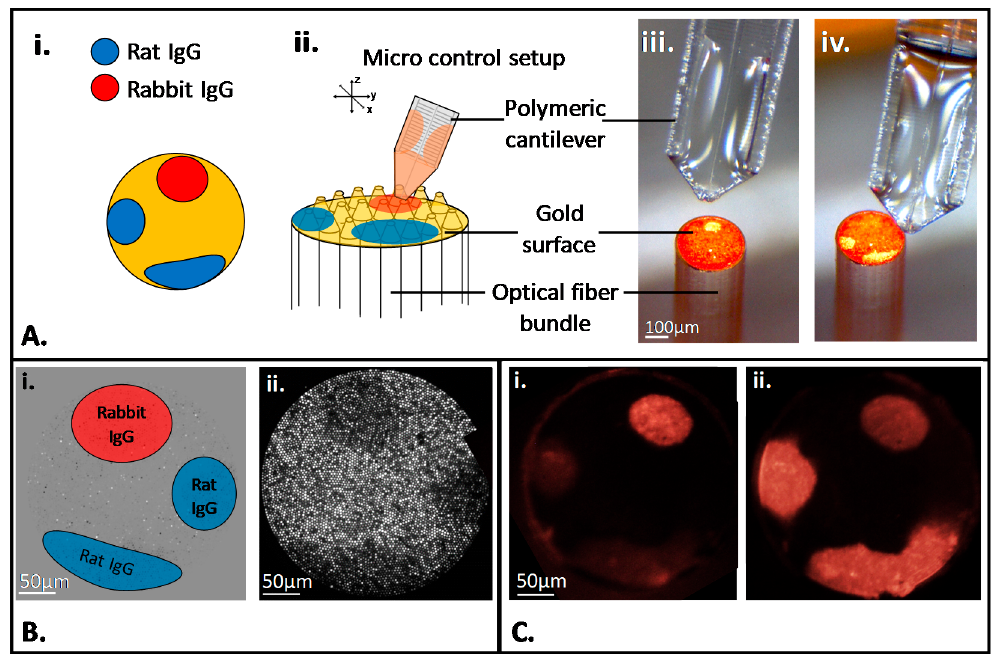
Figure 2. ( A ) multifunctionalization of the microstructured gold coated surface according to i. Spotting map, and ii. Scheme of the deposition, with the image corresponding to iii. Rabbit-IgG spot formation, iv. Rat IgG spots formation. Insert in ( A ) ii. Scanning Electron Microscopy (SEM) image of the microstructured gold coated surface. ( B ). Surface Plasmon Resonance (SPR) view of the droplets deposition with i. Spotting map on subtracted image, ii. Image of the retro-reflected light; ( C ) confirmation of the immobilization and antibodies detection by fluorescence microscopy with streptavidin-Phycoerythrin after addition of the biotinylated antibodies: i. Anti-rabbit and ii. Anti-rat.